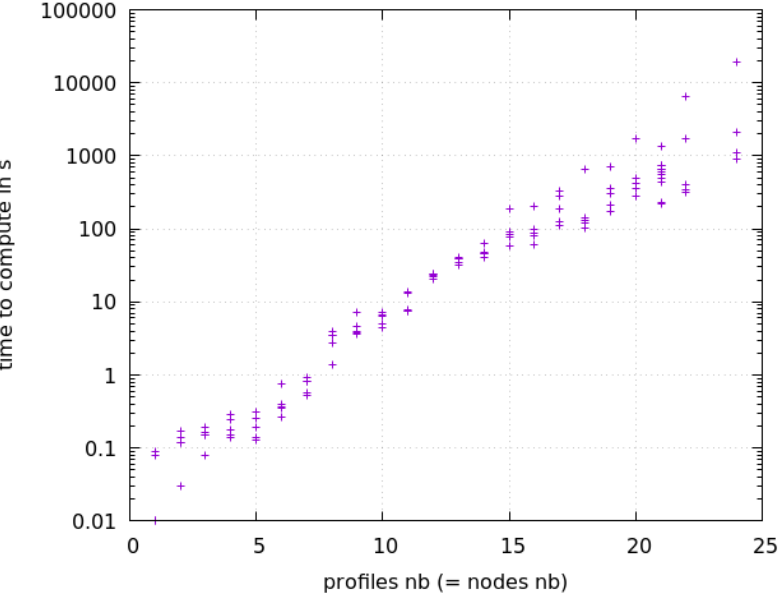
Figure 4. Scaling representation with attacker profiles number = node